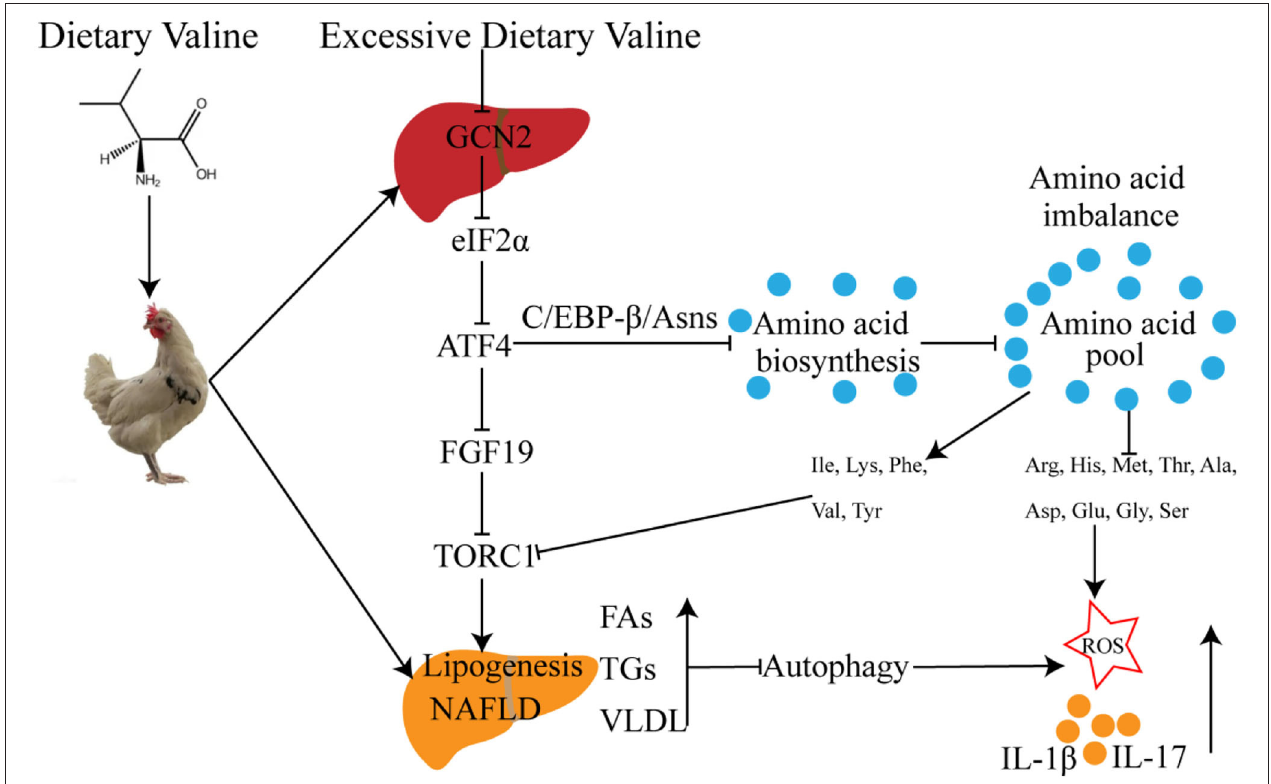
FIGURE 8 | The possible molecular mechanism of dietary valine regulates amino acid and fatty acid metabolism mediated by the GCN2-TORC1-Autophagy pathway in NAFLD of laying hens.